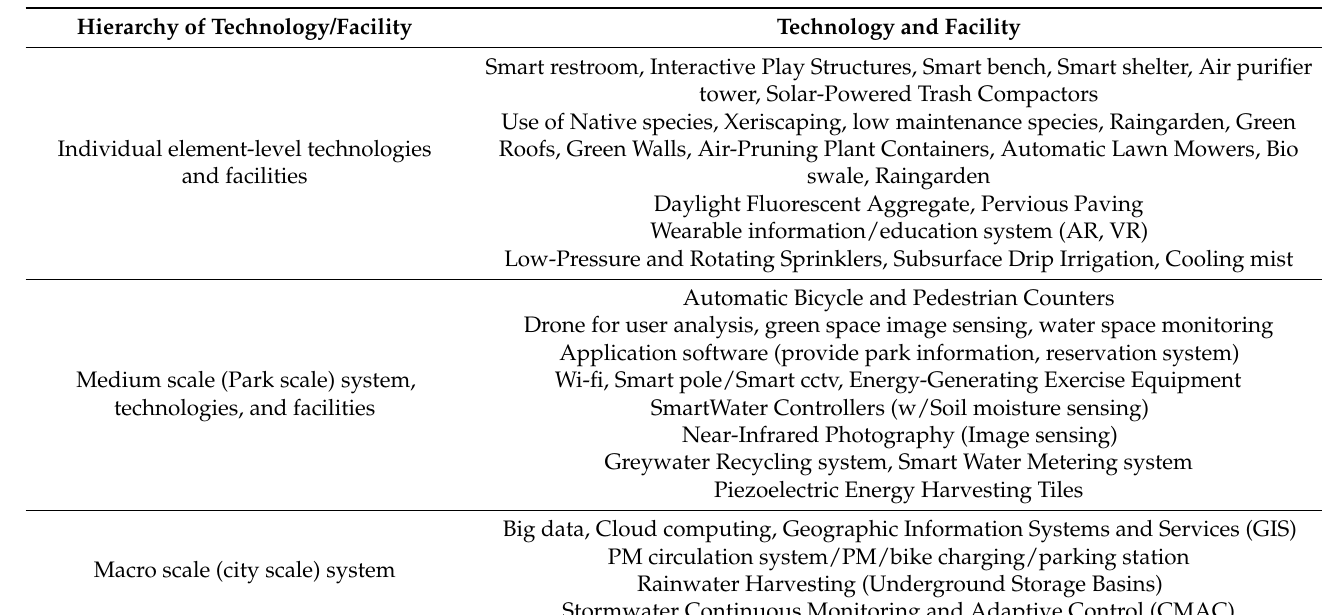
Table 6. Hierarchies of technologies and